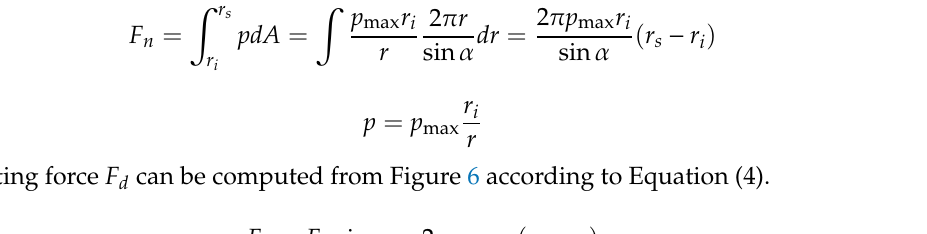
Figure 6. Cone–collet contact pressure.